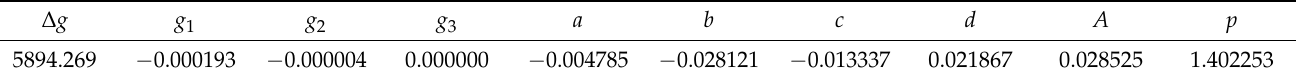
Table 3. Tidal parameters estimated in gravity model (8).